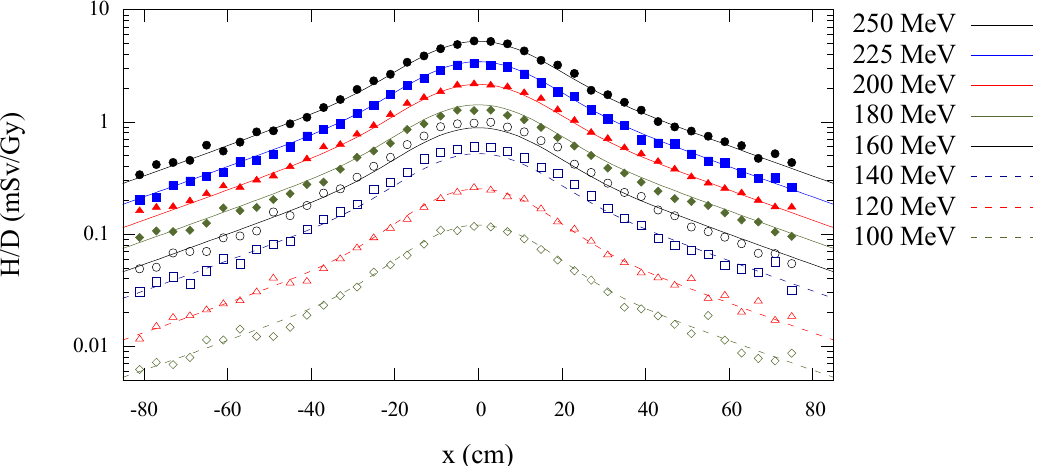
Figure 8. Predictions from Monte Carlo (points) and analytical model (lines) of neutron equivalent dose per treatment dose (𝐻/𝐷) versus off-axis position at 22 cm depth in water for 100 to 250 MeV proton beam energies. Table 1. Parameters for power law relationship for (𝐻/𝐷)